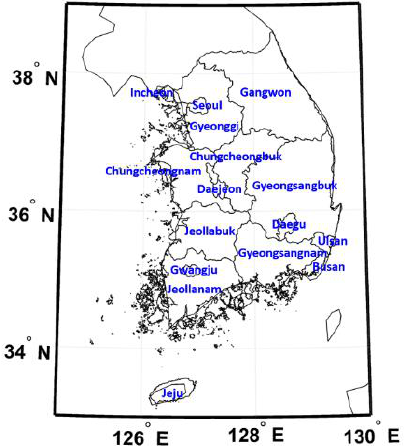
Figure 1. Map of South Korea showing the provinces and major cities.